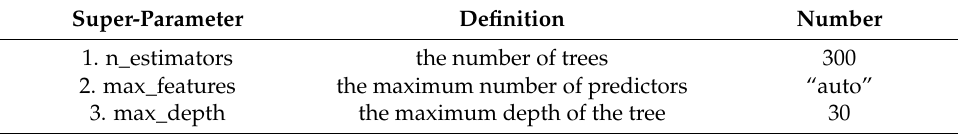
Table 3. Super-parameters used in RF-based